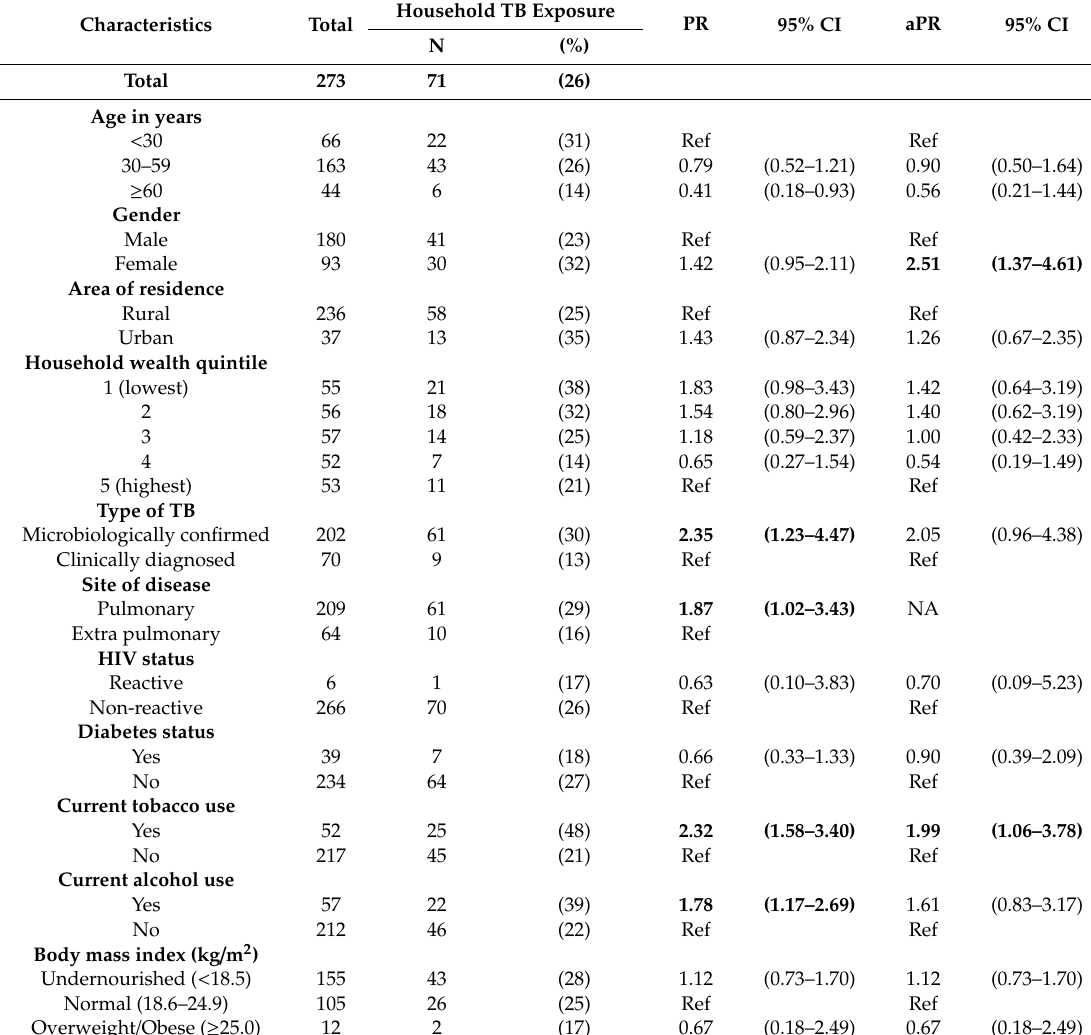
Table 2. Clinical and socio-demographic factors associated with the history of household TB exposure among new TB patients started on treatment in Udupi district, Karnataka, India from October 2018 to June